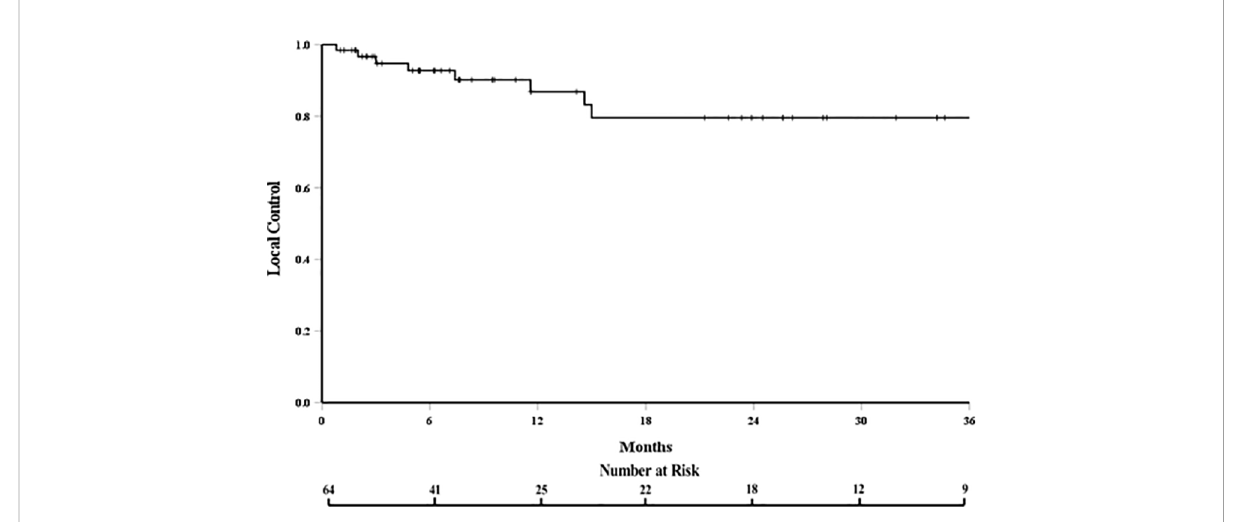
FIGURE 1 Local control